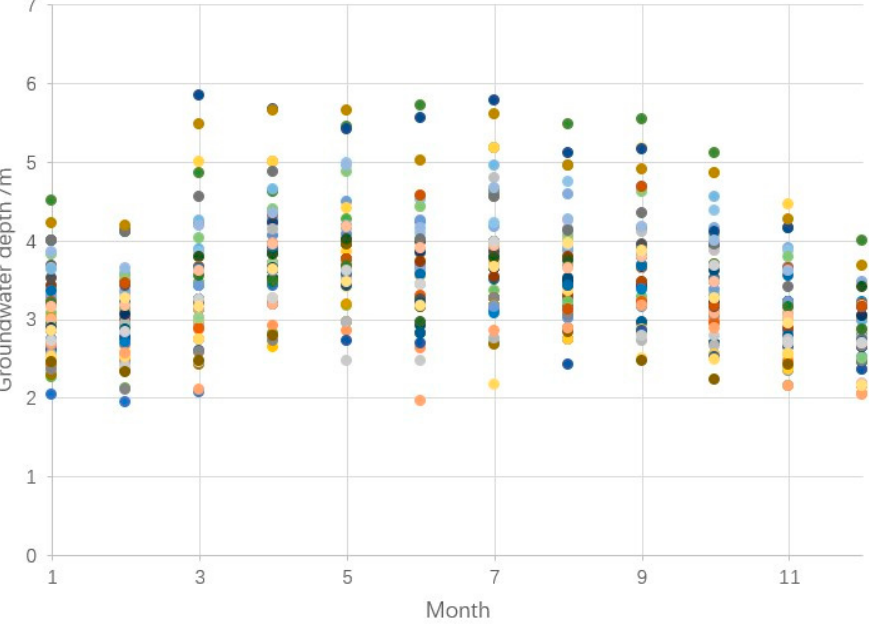
Figure 2. Seasonal changes in groundwater depth.